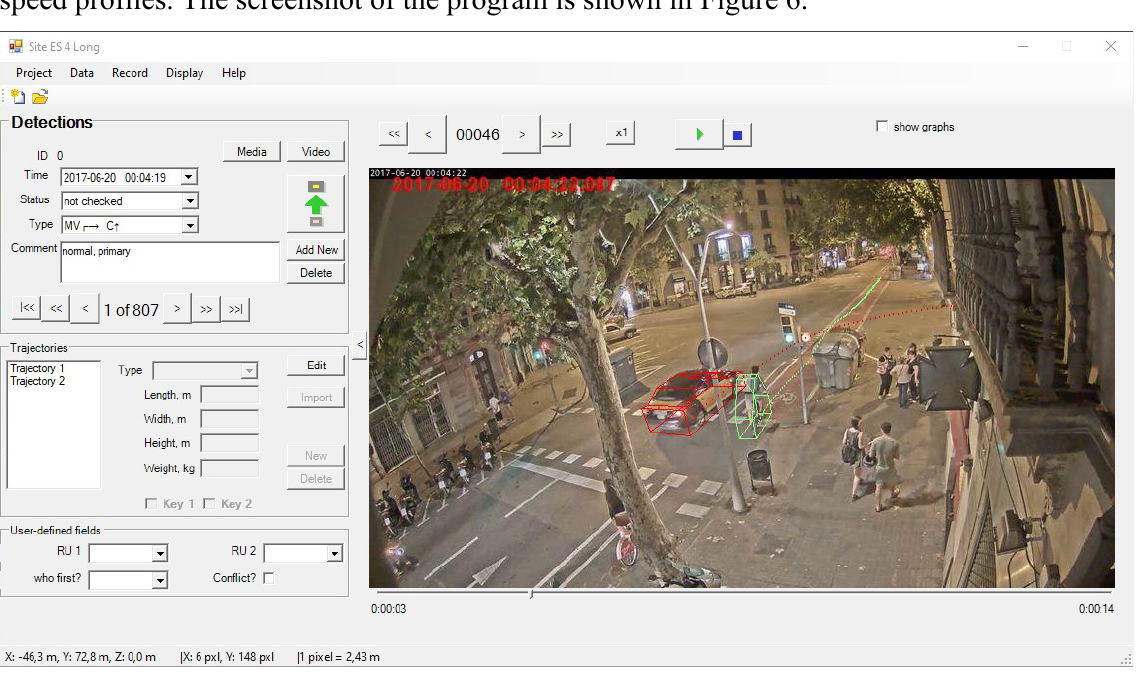
Figure 6 Screenshot of T-Analyst